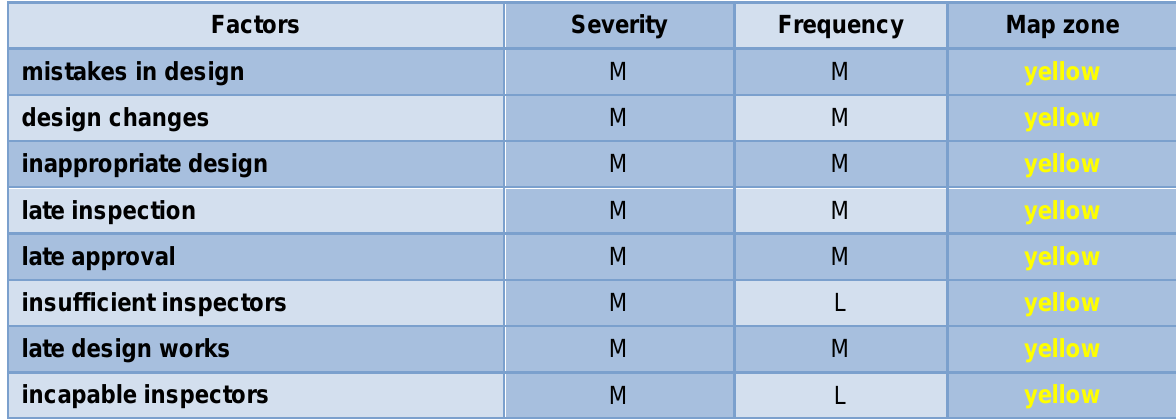
Table 4 Risk map for factors under consultant group